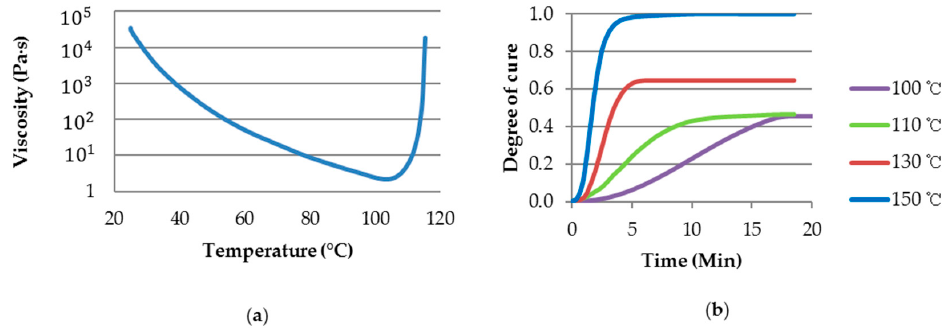
Figure 3. ( a ) Viscosity dynamic scan; ( b ) Degree of cure versus time at different temperatures for the fast-cure epoxy resin.